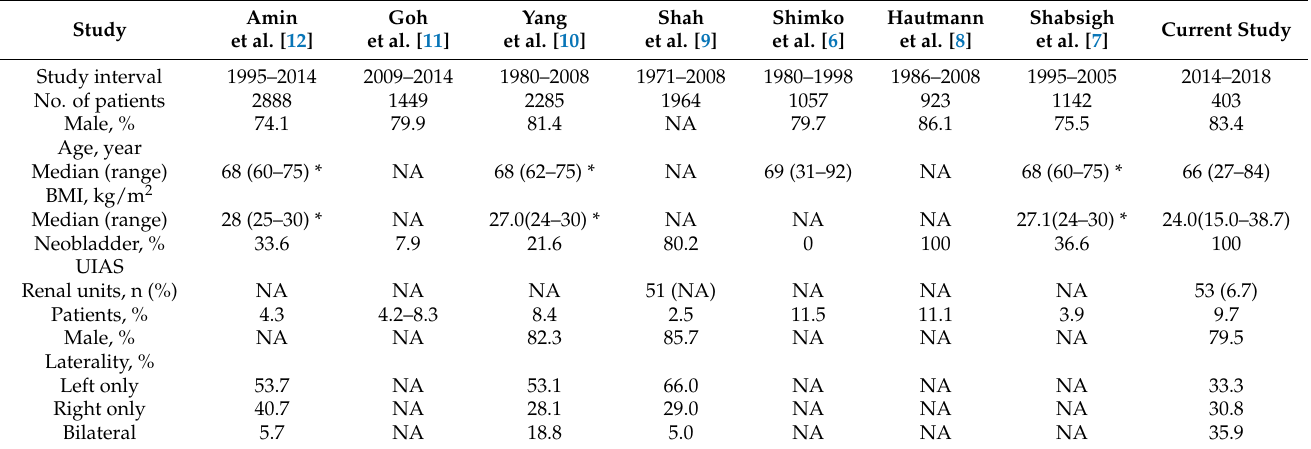
Table 2. Comparison of uretero-intestinal anastomosis stricture between current study and large cohort studies with intraoperative ureteral stent indwelling during radical cystectomy.